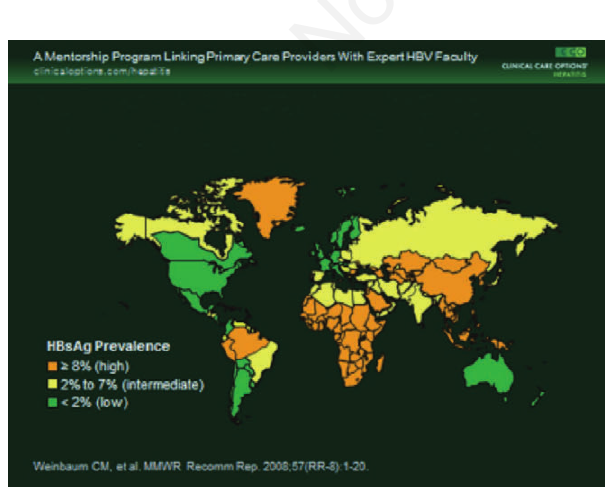
Figure 3. Acute HBV infection incidence in the US